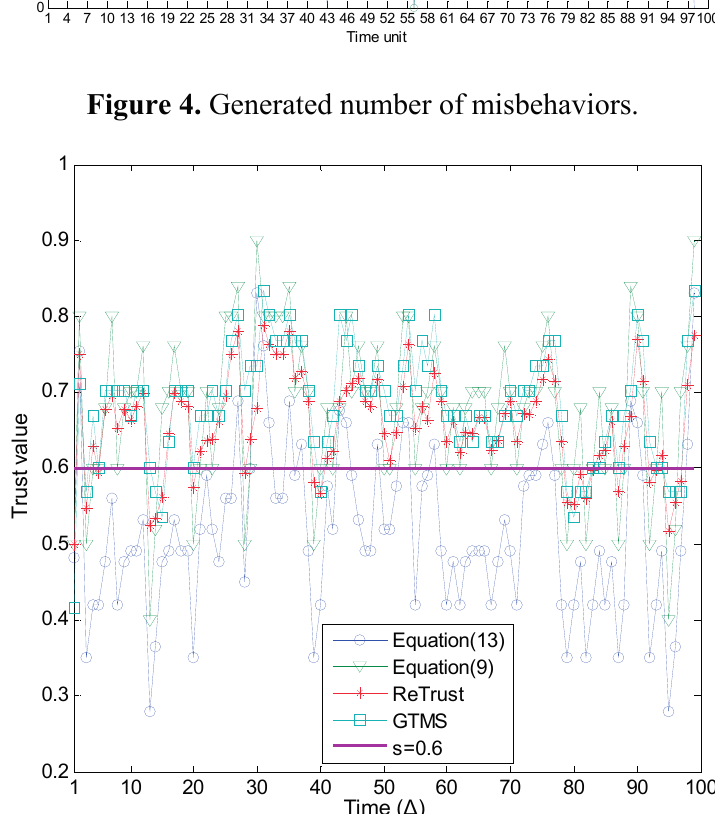
Figure 5. Misbehavior detection ( p ≥